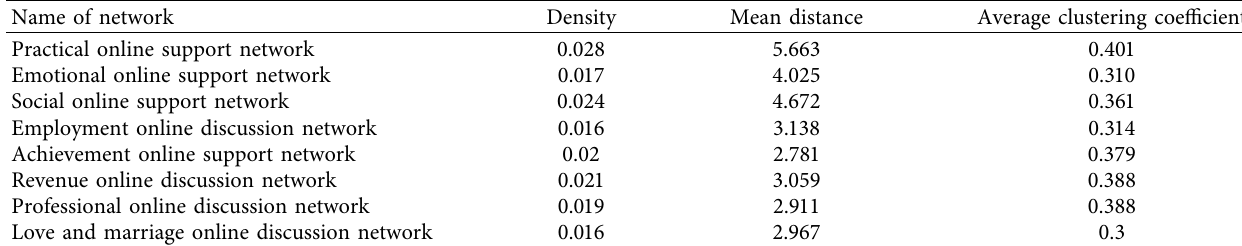
Table 2: The viscosity characteristics of online social